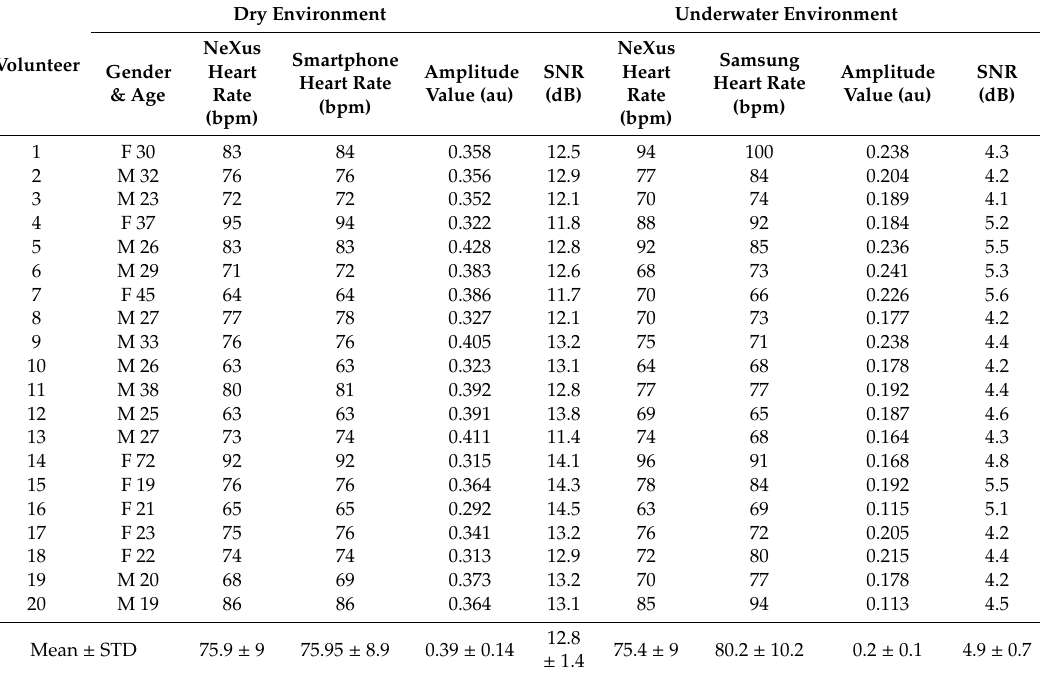
Table 2. Heart rate estimation, amplitude and SNR values from the NeXus-10 MKII device and Samsung Galaxy Note8 for dry and underwater environments at baseline temperature (18 ◦